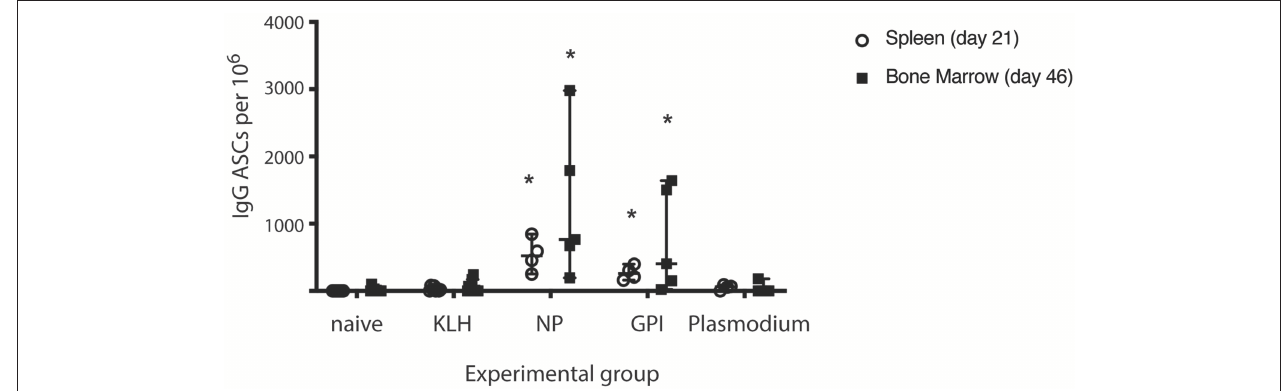
FIGURE 2 | Synthetic GPI-KLH vaccination induced antigen-specific IgG antibody secreting cells (ASCs) in spleen (day 21) and bone marrow (day 46). Mice were vaccinated and boosted with NP-KLH ( n = 5), GPI-KLH ( n = 5), or KLH alone ( n = 5) (20 µ g/ µ L) or infected twice with 10 6 pRBCs then 10 4 pRBCs (Plasmodium, n = 5). Naïve mice ( n = 5) were included as a baseline. Splenocytes (open circles, day 21), or lymphocytes (filled squares, day 46) were isolated from the spleen and bone marrow, respectively, and cell counts of antibody secreting cells (ASCs) were quantitated. Pooled data from all mice are represented as median ± 95%-CI. Data was analyzed using the non-parametric Kruskal-Wallis test and differences determined by Dunn’s multiple comparisons test. Significance was determined at P < 0.05. *Statistically higher than naïve, KLH-vaccinated, or Plasmodium mice at both day 21 and 46. P <